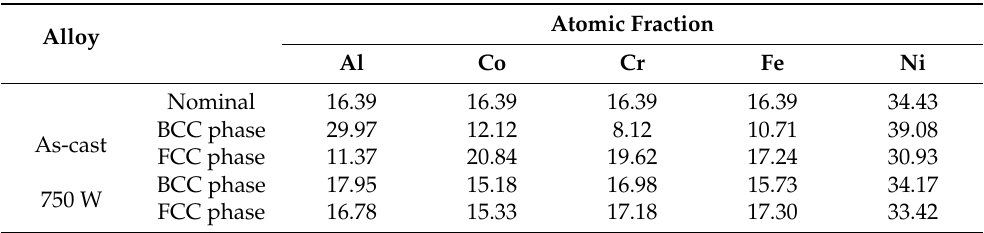
Table 1. EDS analysis of the FCC and BCC phases of the AlCoCrFeNi 2.1 HEA before and after laser surface